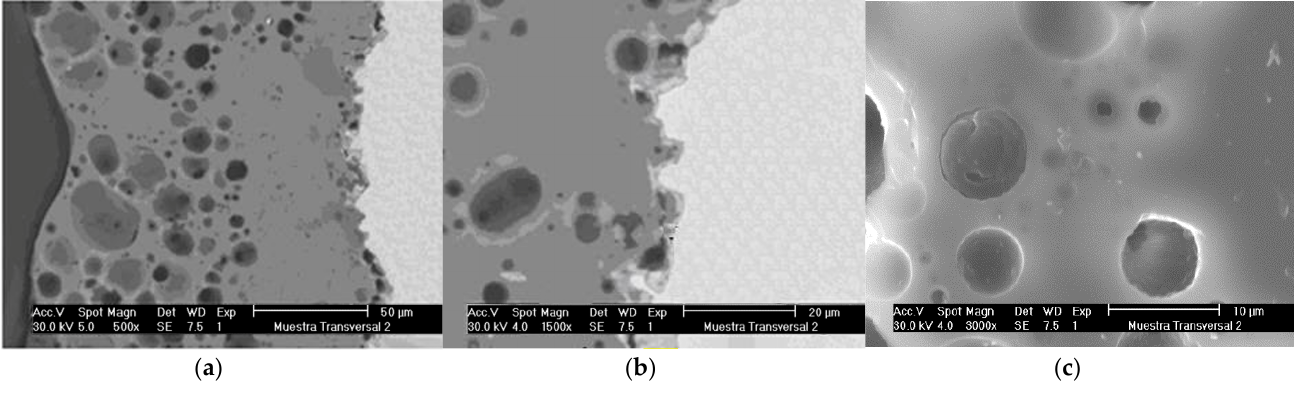
Figure 2 . Microphotographs (SEM) of the protective coating fired at 850 °C ( a , b ) and at 820 °C ( c ). The coating fired at 820 °C is characterized with a very low content of the crystalline phases (Figure 3b) and contains pores near the coating-steel interface (Figure 3b). It is necessary to note that for the coarse glass powder treated at 820 °C the XRD patterns do not present any reflections of crystalline phases (Figure 1b), whereas, in the structure of the protective coating based on thin glass powder with some additives (clay, borax), several pores demonstrate initial stages of the surface crystallization (Figure 3b), although in the most part of these pores a surface is free of crystals (Figure 3c).